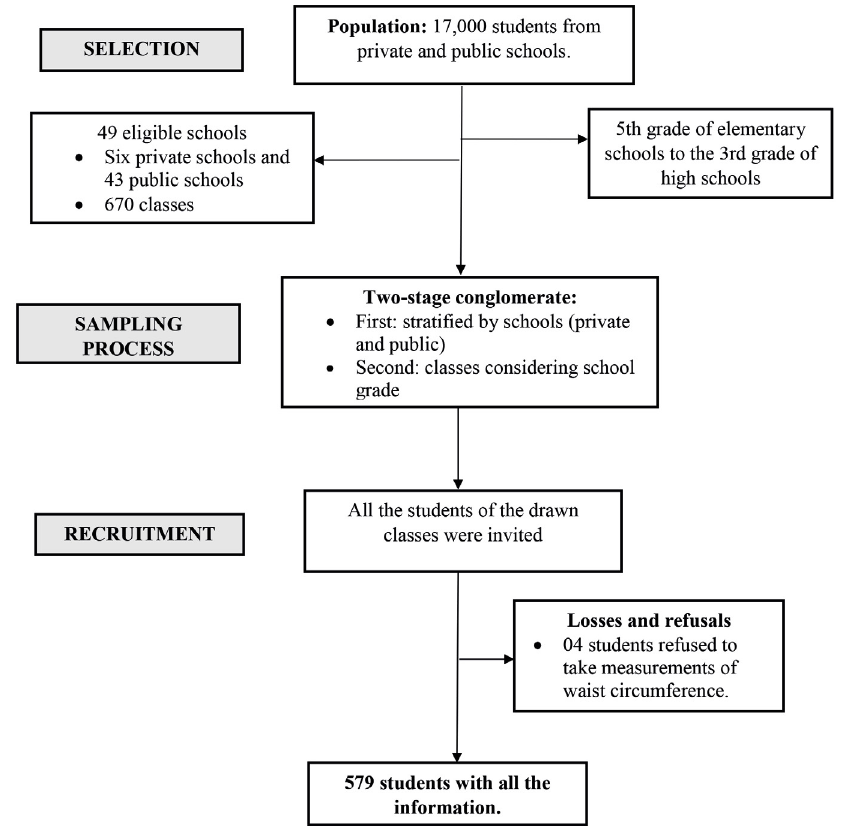
Figure 1. Flowchart of the sampling process of the present